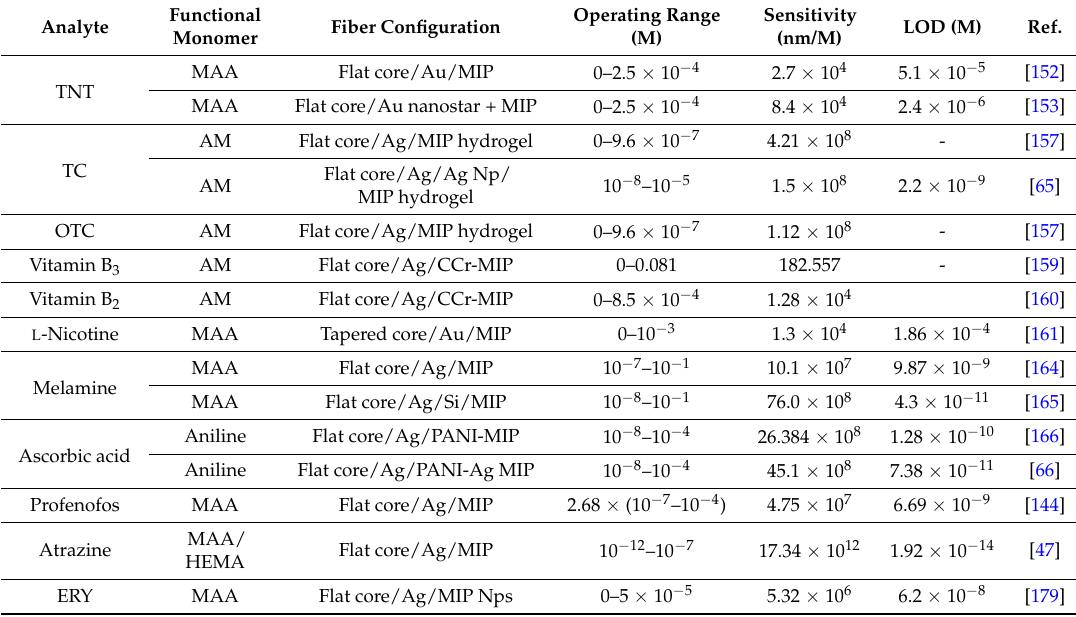
The following are the abbreviations and expansions used in Table 3: TNT—trinitrotoluene, MAA—methacrylic acid, TC—tetracycline, OTC—oxytetracycline, AM—acrylamide, CCr—colloidal crystal,